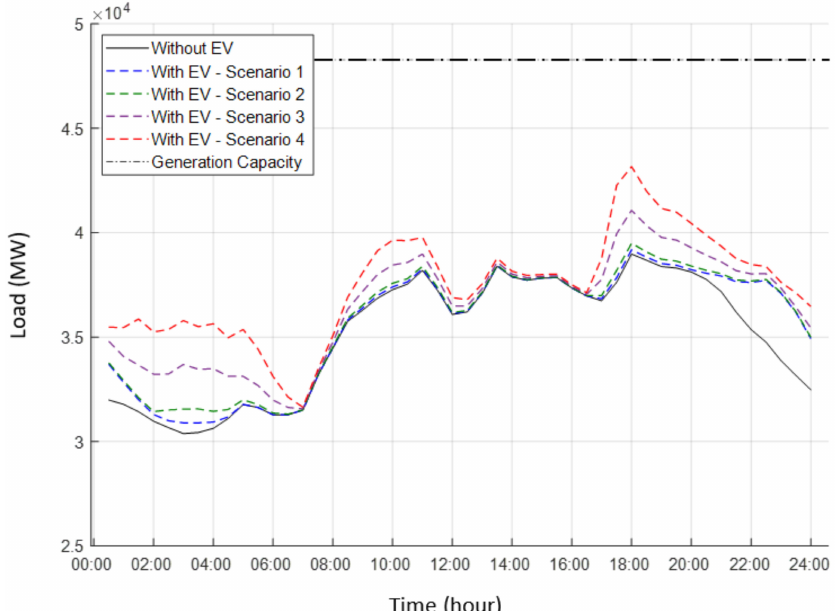
Figure 6. Java-Bali forecasted load profile with various EV integration scenario in smart scheduling